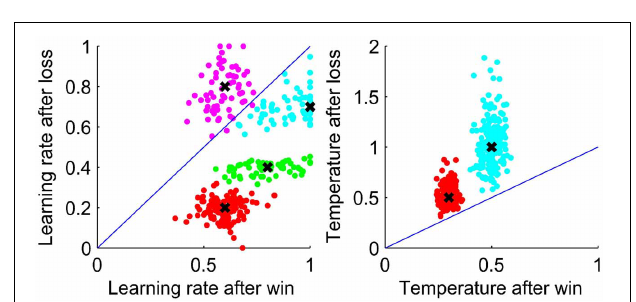
rule 2 applied. The participants’ responses are shown as 1 for type 2 responses, and 0 for type 1, responses which were rewarded are shown as green diamonds and those which were penalized as red circles.